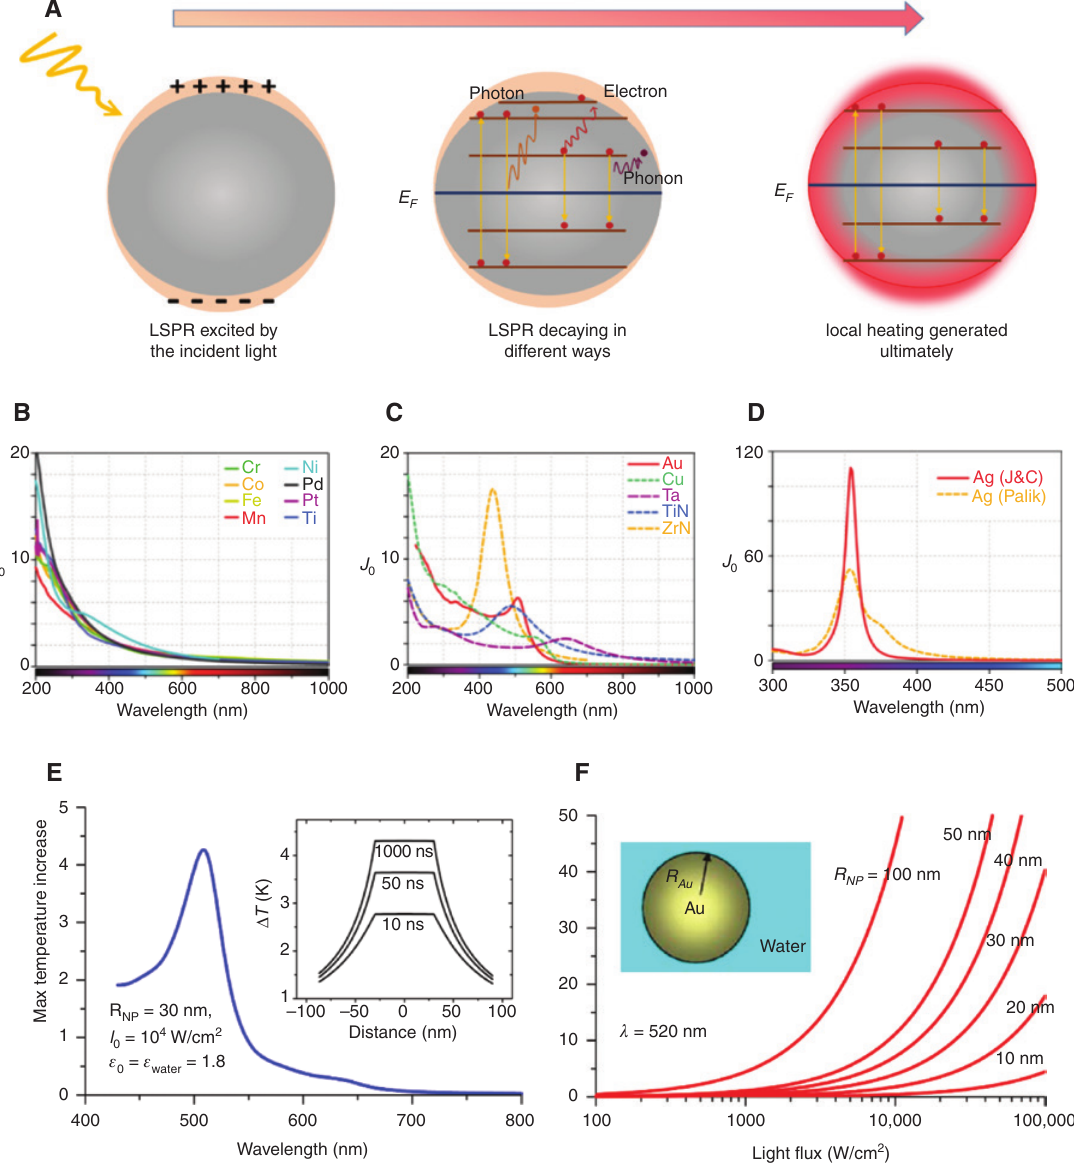
Figure 5: Plasmonic heat generation. (A) Schematic of local heat generation process; (B)–(D) the comparison of Joule parameter for different materials [65]; (E) and (F) the calculated localized heating at the surface of Au NPs in the water for different incident light wavelength, distance (E) (inset: spatial distribution of temperature at different times) and the particle size (F) [25]. (B)–(D) Reprinted with permission from Ref. [65]. Copyright 2015 American Chemical Society. (E) and (F) Reprinted with permission from Ref. [25]. Copyright 2006